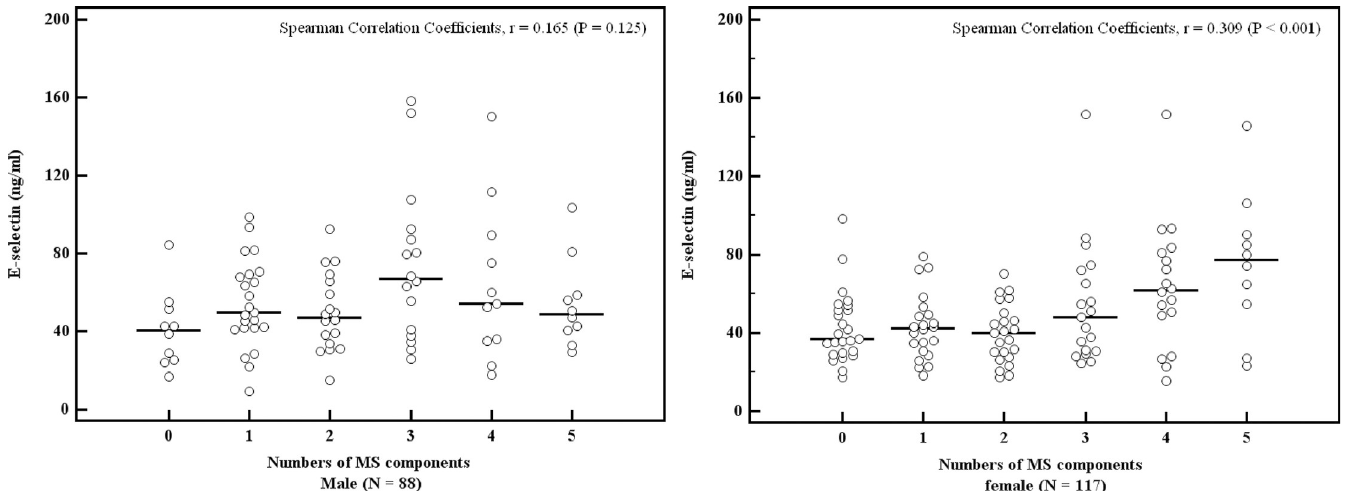
Fig 1. The level of plasma E-selectin concentration across different numbers of MS components (0 to 5 components) by gender. The circles represent individual values of each patient, and the lines represent median values in each category.